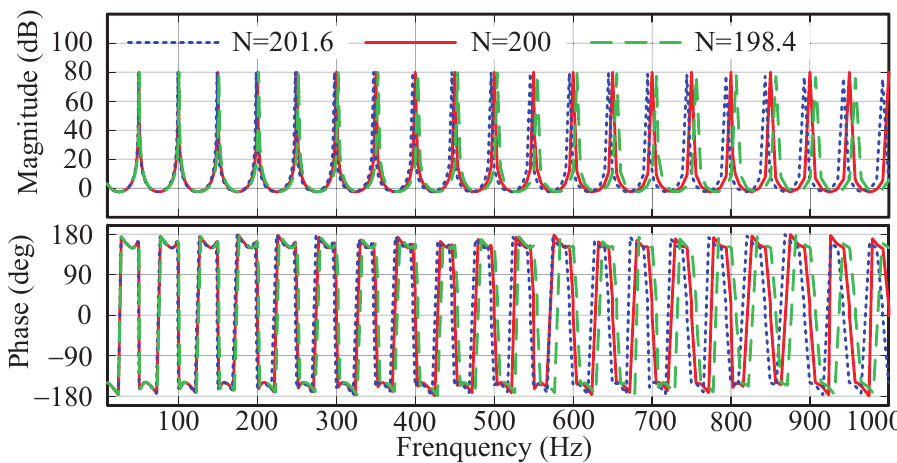
Figure 12. Bode diagrams of IRC ( N = 200) and FA-IRC ( N = 198.4 and 201.6).